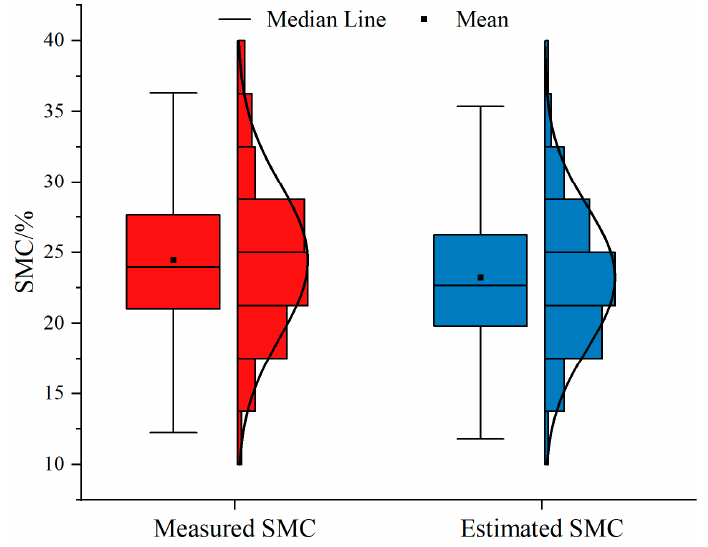
Figure 12. Boxplots of measured and estimated SMC values based on the optimal